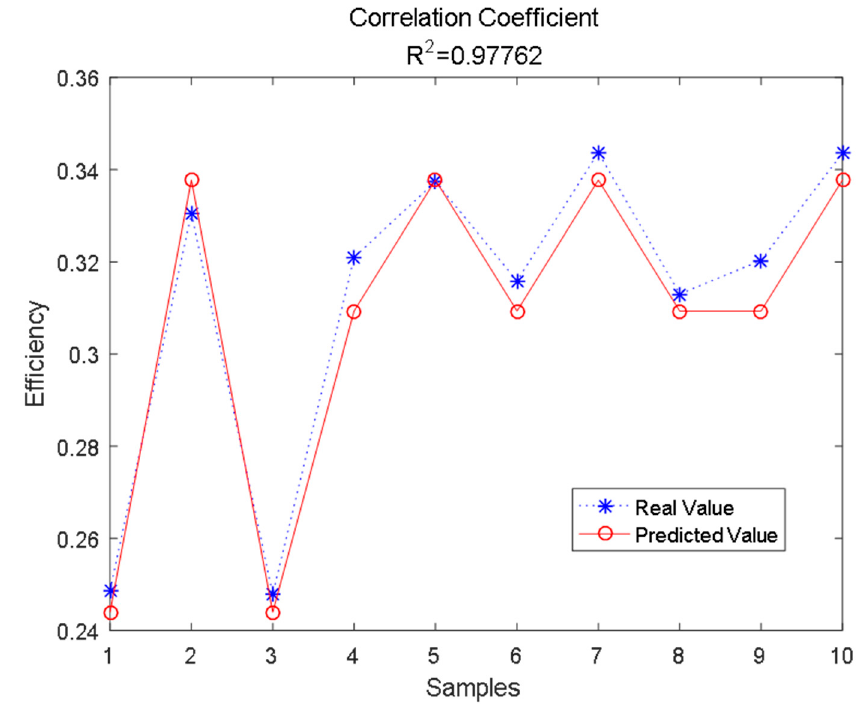
Figure 7. Efficiency predicted value by BP without learning rate optimization ( η = 0.1).